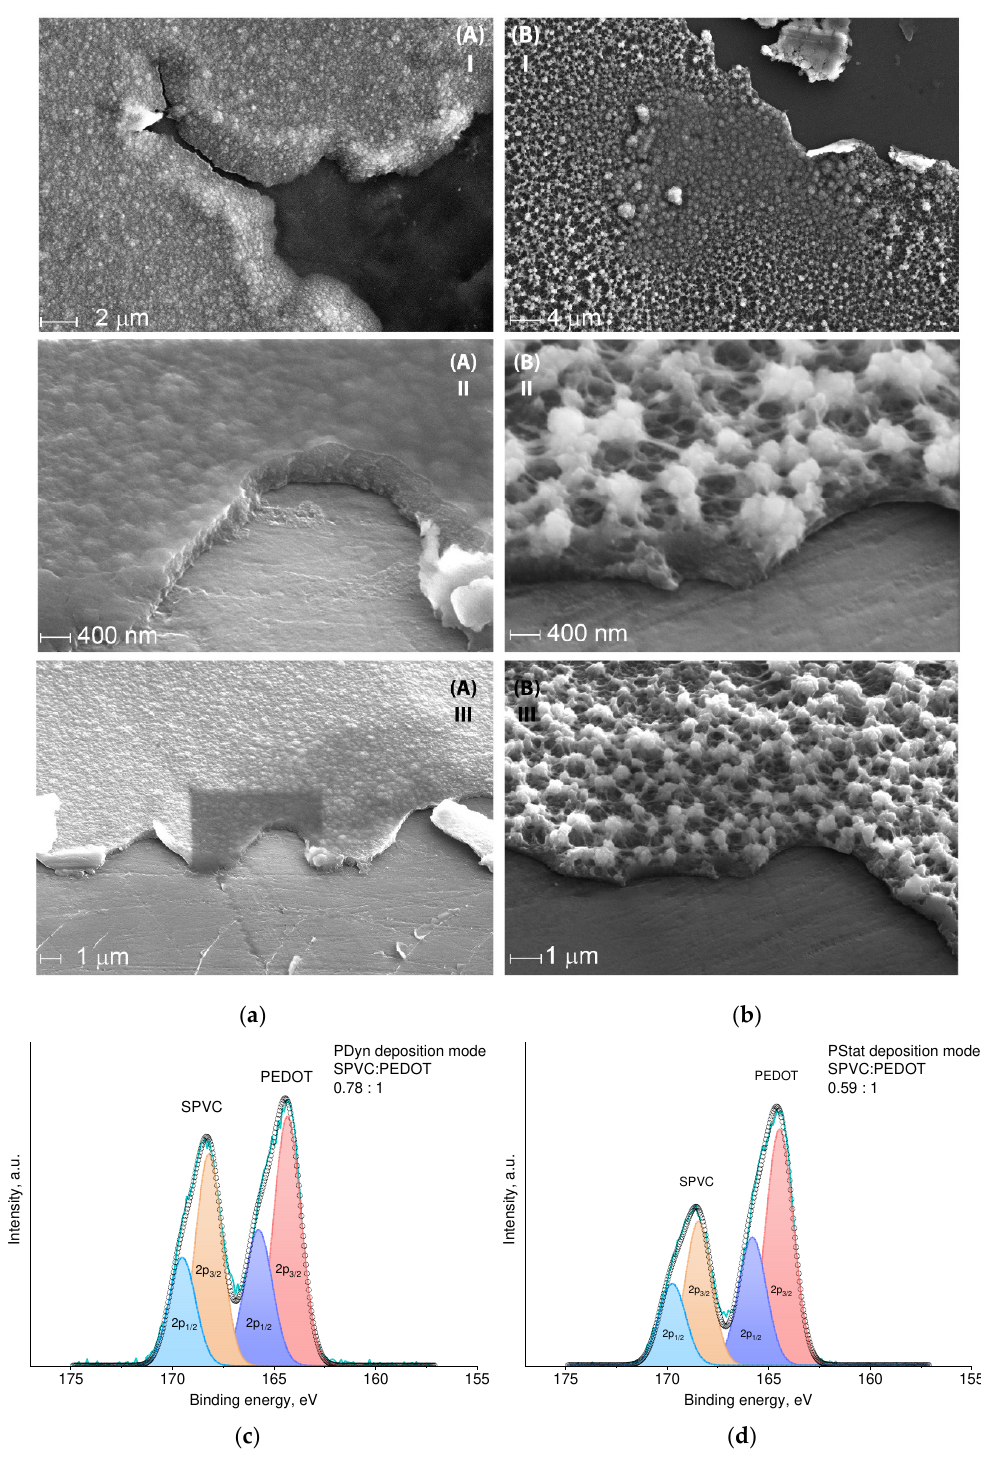
Figure 7. SEM images of ( a ) PDyn and ( b ) PStat films at different magnifications; ( c , d ) fitted XPS spectra of PDyn and PStat films.